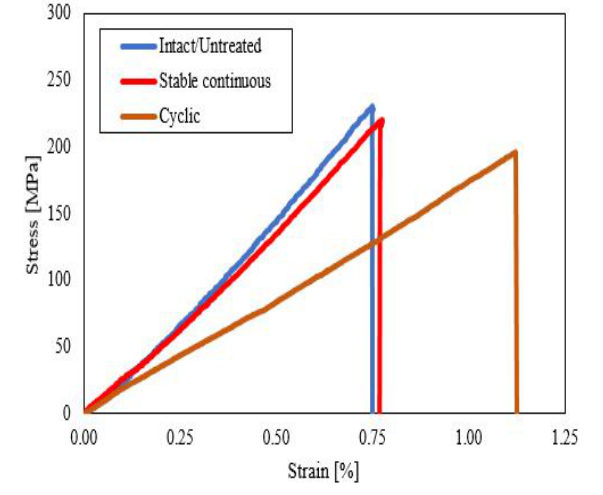
Figure 7. Average stress–strain curve for the tensile